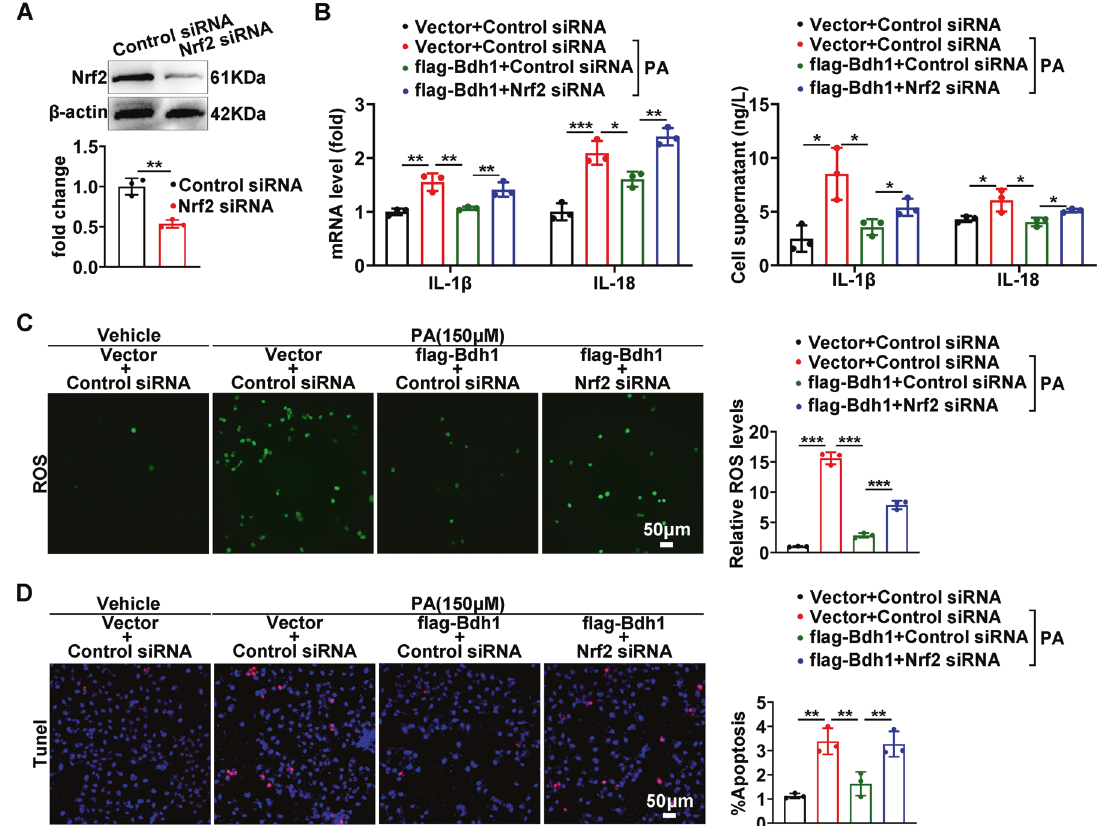
Fig. 5 Bdh1 ameliorates PA-induced lipotoxicity through Nrf2. A Representative western blots showing the protein level of Nrf2 in LO2 cells transfected with control siRNA and Nrf2 siRNA. B mRNA levels (above) and cell culture supernatant concentrations (below) of IL-1 β and IL-18 in LO2 cells with indicated treatment. C DCFH-DA probe was used to detect the level of ROS in LO2 cells with indicated treatment. D TUNEL assay showing the apoptosis level of LO2 cells with indicated treatment. Before indicated assay, LO2 cells were transfected with vector or fl